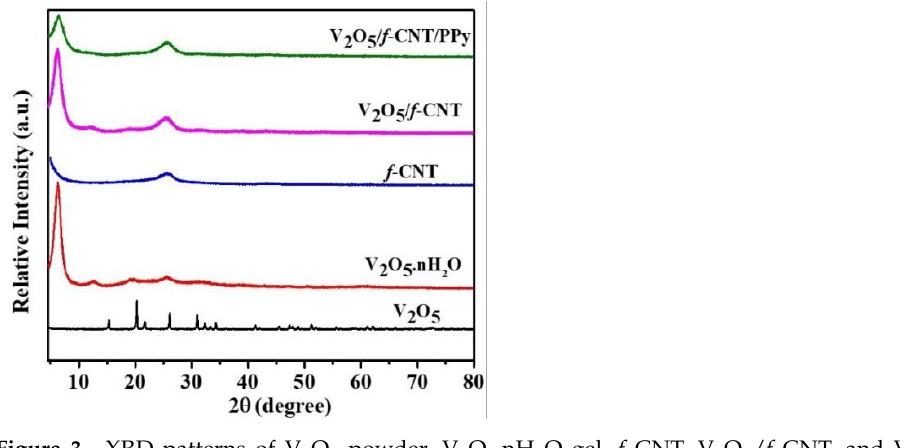
Figure 3. XRD patterns of V 2 O 5 powder, V 2 O 5 .nH 2 O gel, f -CNT, V 2 O 5 / f -CNT, and V 2 O 5 / f -CNT/PPy. TGA thermograms of V 2 O 5 powder, V 2 O 5 gel, V 2 O 5 / f -CNT, and V 2 O 5 / f -CNT/PPy com-